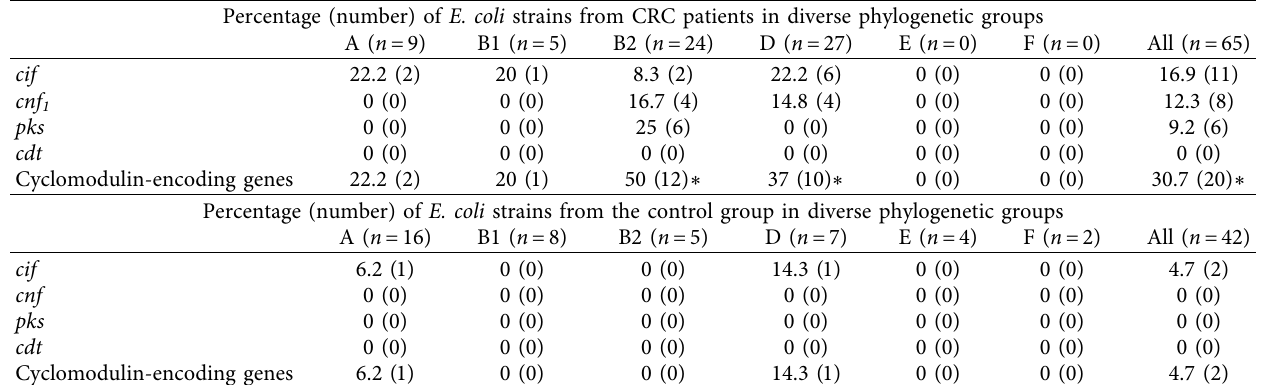
Table 3: Distribution of cyclomodulin-positive E. coli according to phylogenetic groups.